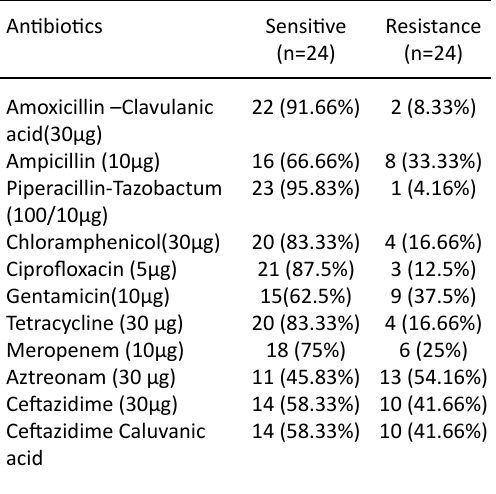
Table 3. Antibiotic Susceptibility Profile for Gram Negative Bacilli